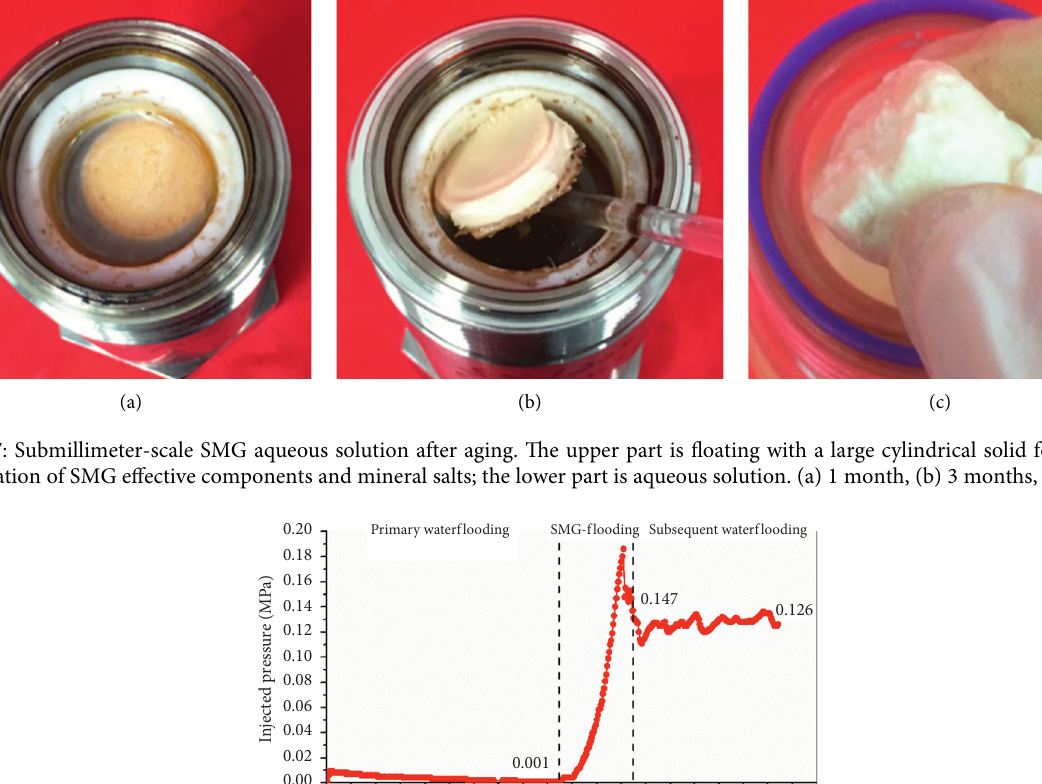
R ) and residual resistance factor ( F RR )